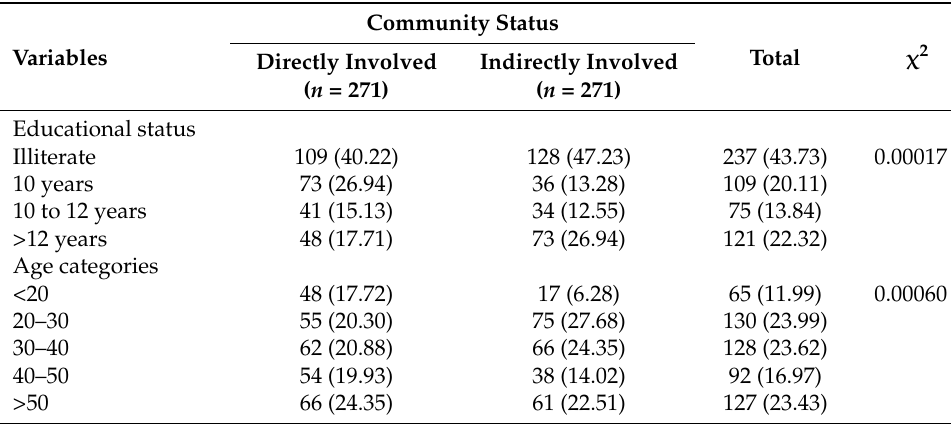
Table 8. Educational status age categories of the